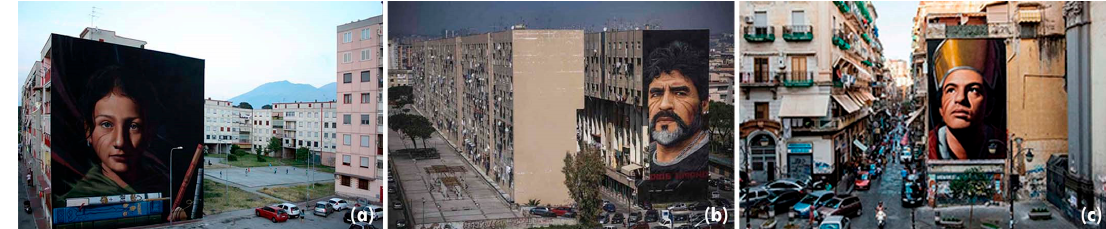
Figure 4. Jorit Agoch: ( a ) Ael, Tutt’egual song’e criature; ( b ) Dios umano; ( c ) San